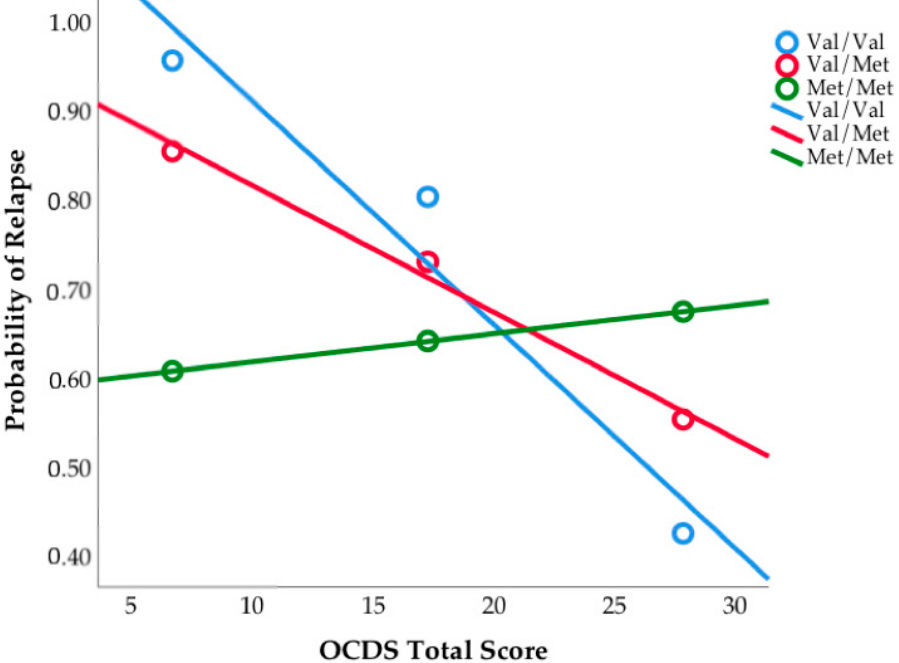
Figure 4. The relationship between Obsessive Compulsive Drinking Scale total score and relapse was moderated by COMT genotype. Figure depicts probability of relapse six months